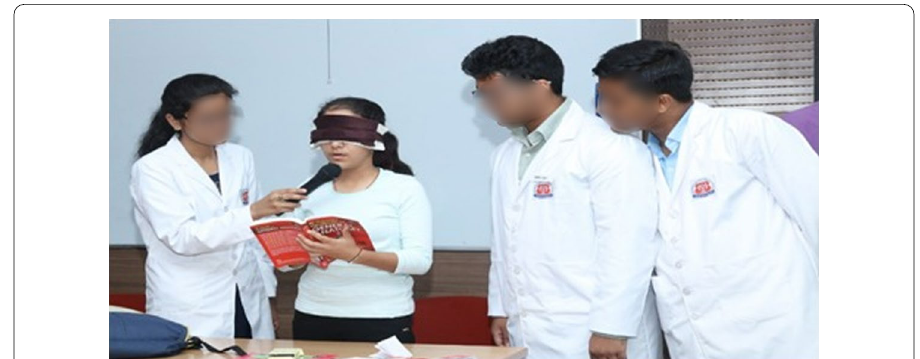
Fig. 1 Live demonstration of brighter minds based cognitive skill training